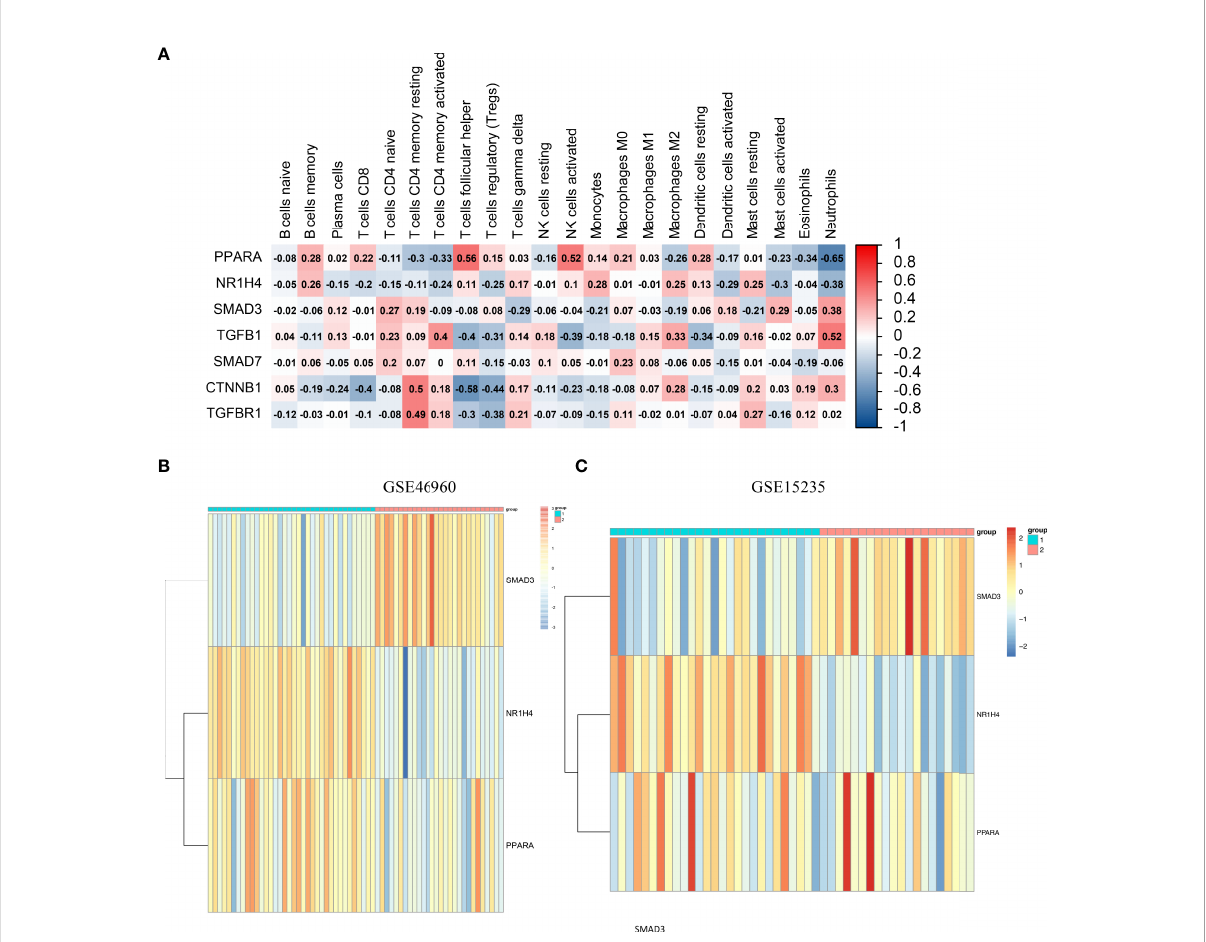
FIGURE 4 Consensus clustering and immune cell in fi ltration analysis based on SMAD3, PPAR a , and NR1H4. (A) Correlation heatmap of PPAR a , NR1H4, and the major genes of the TGF b pathway. (B) GSE46960 patient rooting PPAR a , NR1H4 (FXR), and SMAD3 divisions. (C) GSE15235 patient rooting PPAR a , NR1H4 (FXR), and SMAD3 divisions.